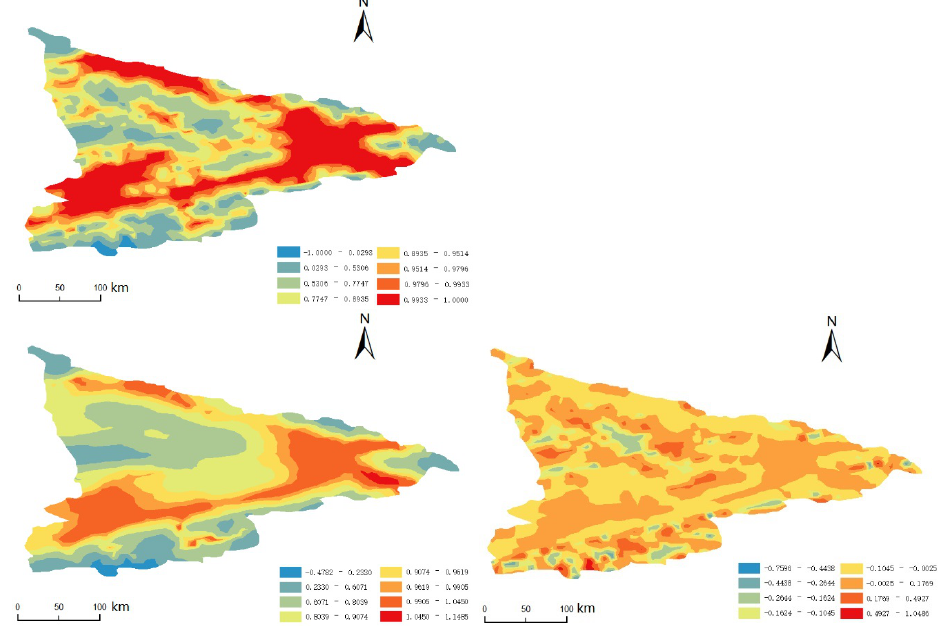
Figure 4. Contour oftrue FVC in the research area ( top row ); The estimated contour and the residual of the FVC with bandwidth matrix H ( bottom row ).